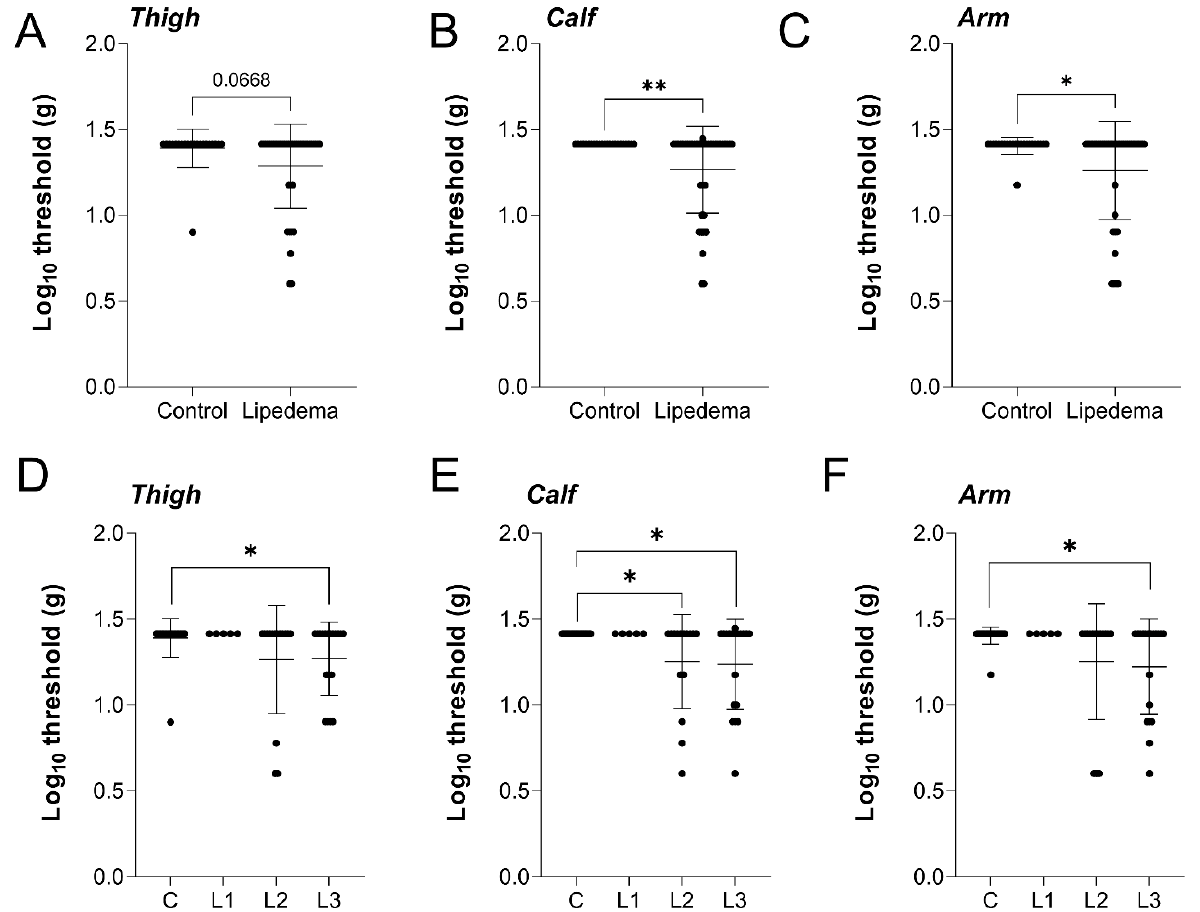
Figure 2. Mechanical von Frey sensitivity assay demonstrates heightened innocuous stimulation for Stage 2 and 3 lipedema patients. Lipedema vs. Control: representation of von Frey pain scores (as log10 fold increase pain intensity) tested in the right-side ( A ) upper lateral thigh, ( B ) anterior calf, and ( C ) upper lateral arm of the body. Lipedema stage-based representation of von Frey pain scores (as log10 fold increase pain intensity) tested in the ( D ) upper lateral thigh ( p = 0.0772 across stages by ANOVA), ( E ) anterior calf ( p = 0.0246 across stages by ANOVA), and ( F ) upper lateral arm ( p = 0.0383 across stages by ANOVA) of the body. Control n = 23, Stage 1 n = 5, Stage 2 n = 13, Stage 3 n = 19. Mean ± SD. ( A – C ) * indicates p < 0.05, ** p < 0.01. ( D – F ) * indicates p < 0.05 by post hoc multiple comparison test.